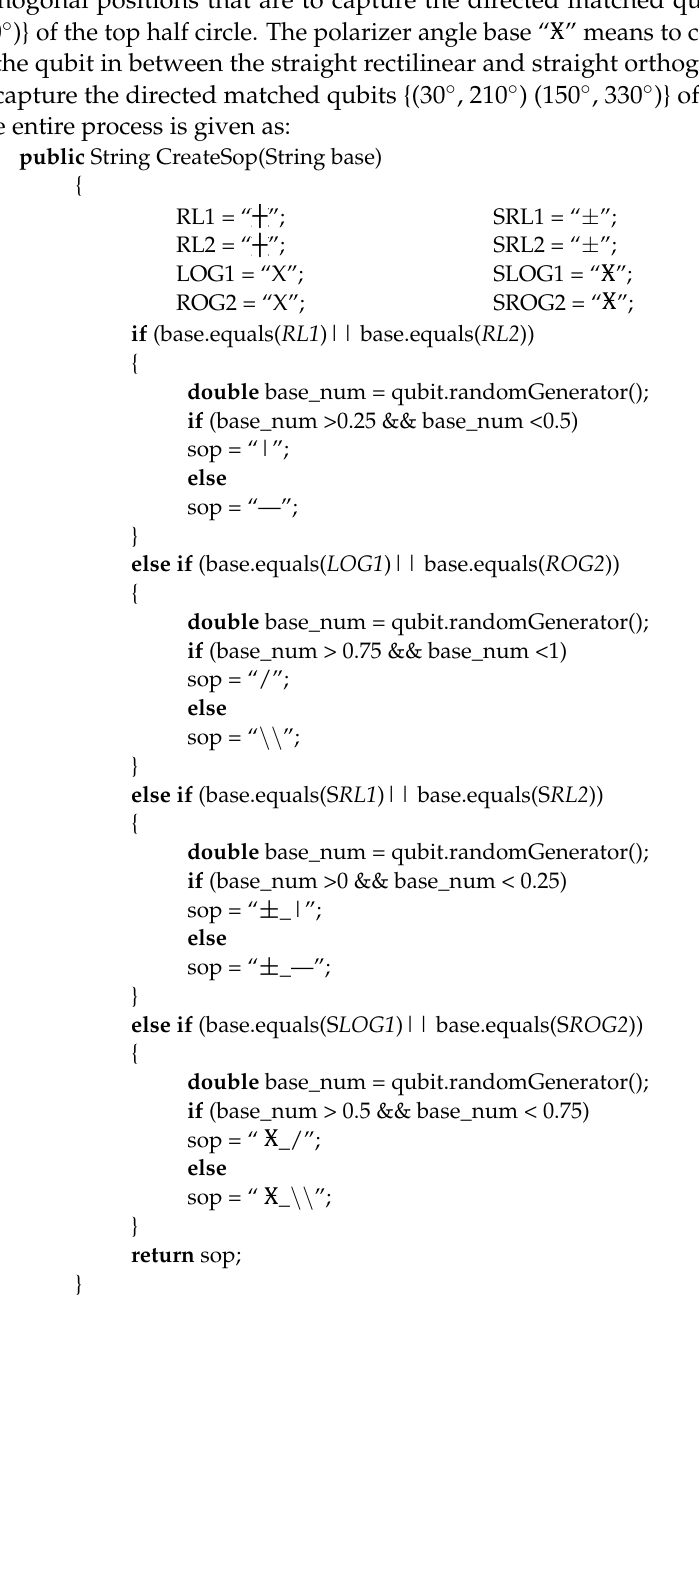
Figure 2. The multi-qubit octal states depiction of the proposed model.